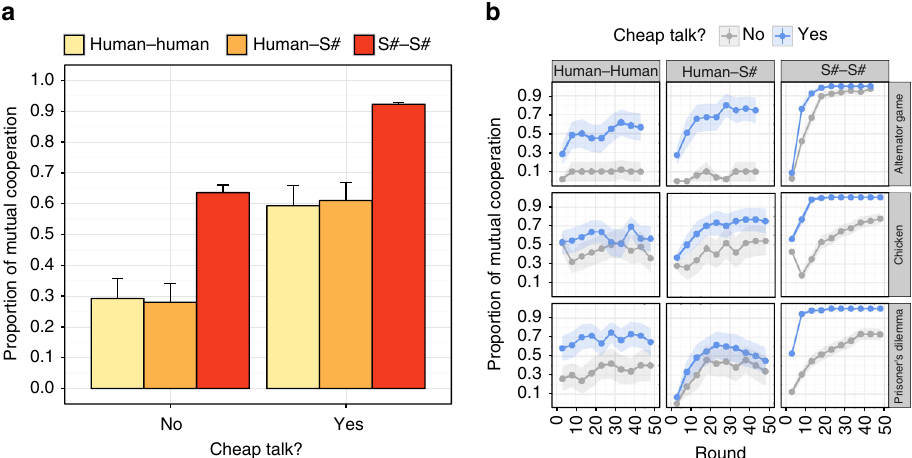
Fig. 4 Proportion of mutual cooperation achieved in the culminating user study. In this study, 66 volunteer participants were paired with each other and S# in three representative games (Chicken, Alternator Game, and Prisoner ’ s Dilemma). Results are shown for when cheap talk was both permitted and not permitted. Note that S# is identical to S++ when cheap talk is not permitted. a The proportion of rounds in which both players cooperated over all rounds and all games. b The proportion of time in which both players cooperated over all games. Bars and lines show average values over all trials, while error bars and ribbons show the standard error of the mean. A full statistical analysis con fi rming the observations shown in this fi gure are provided in Supplementary Note